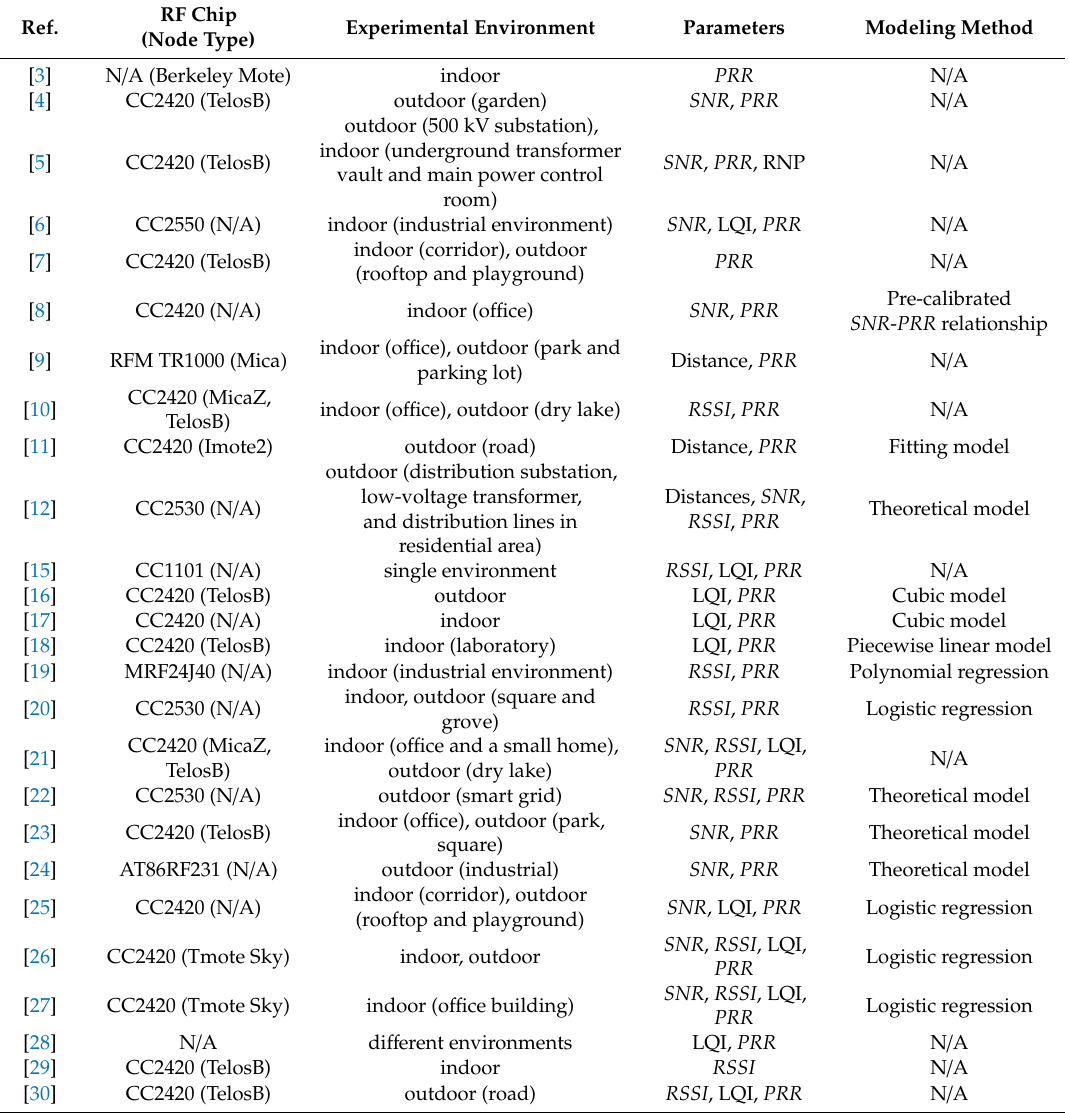
Table 1. Main features of existing